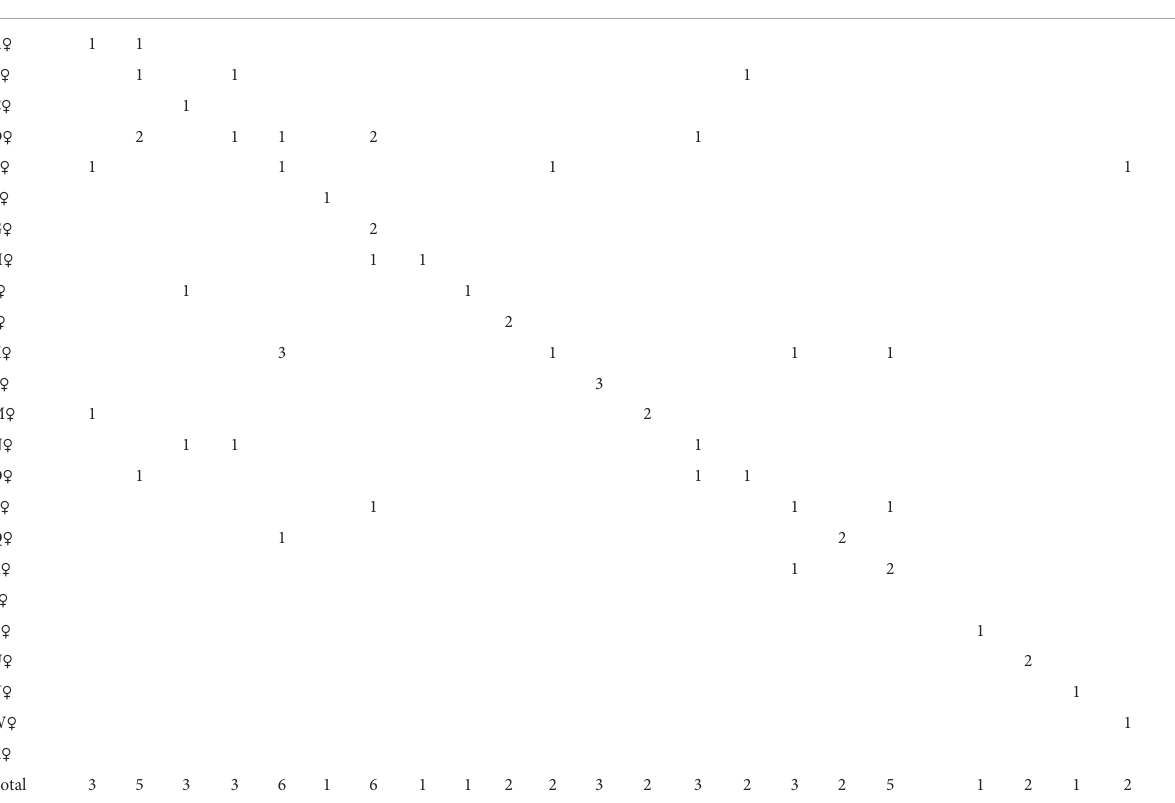
TABLE 1 Incomplete diallel crosses of 24 parents of L. vannamei